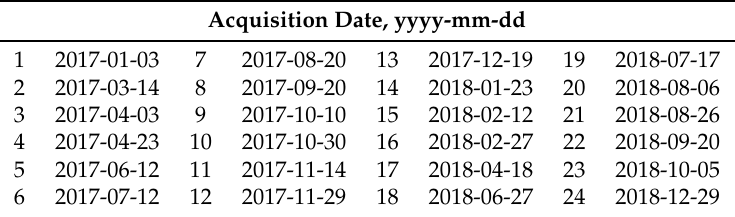
Table 2. Image acquisition dates for the Sentinel-2